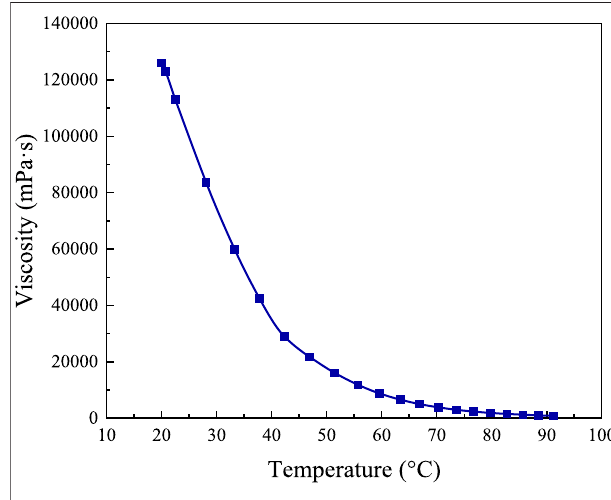
FIGURE 1 | Viscosity-temperature curve for heavy oil in the